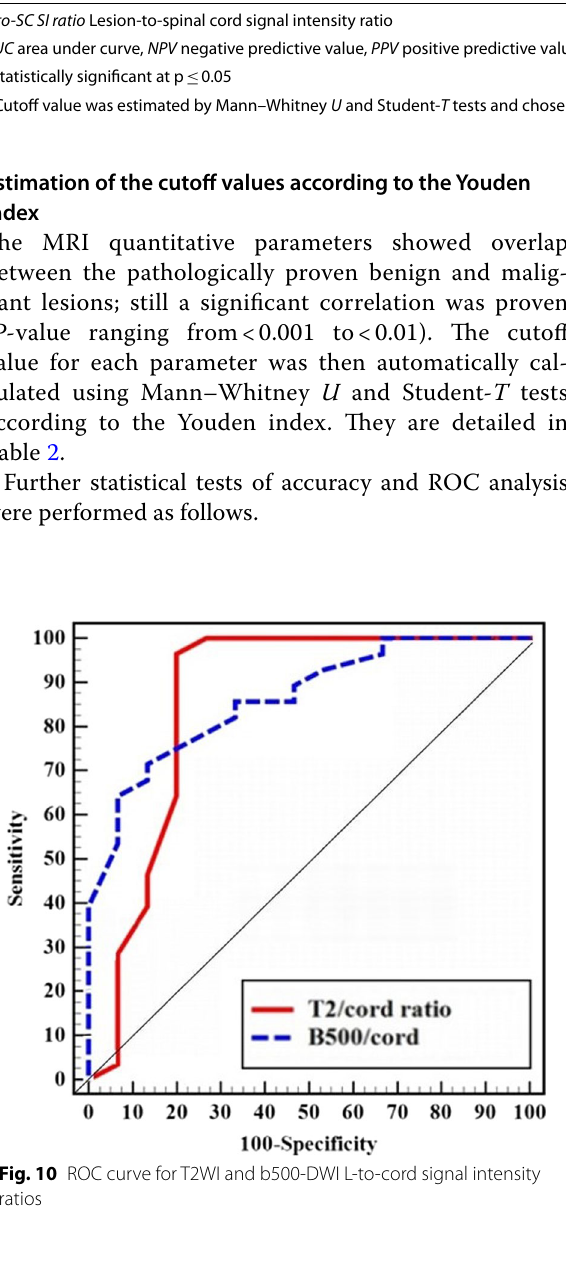
L-to-SC SI ratio Lesion-to-spinal cord signal intensity ratio AUC area under curve, NPV negative predictive value, PPV positive predictive value *Statistically significant at p 0.05 ≤ # Cutoff value was estimated by Mann–Whitney U and Student- T tests and chosen according to Youden index